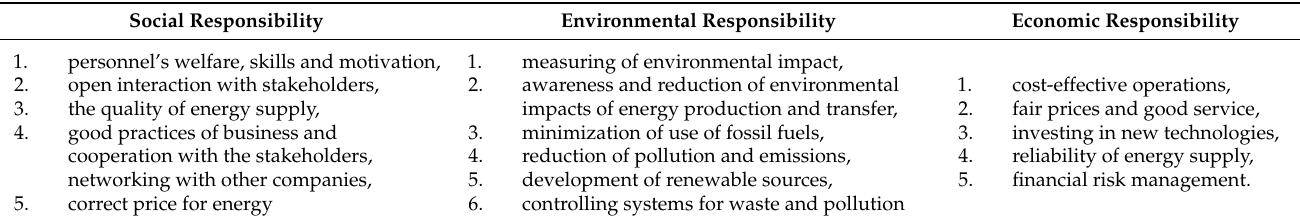
Table 1. Areas of responsibility in energy